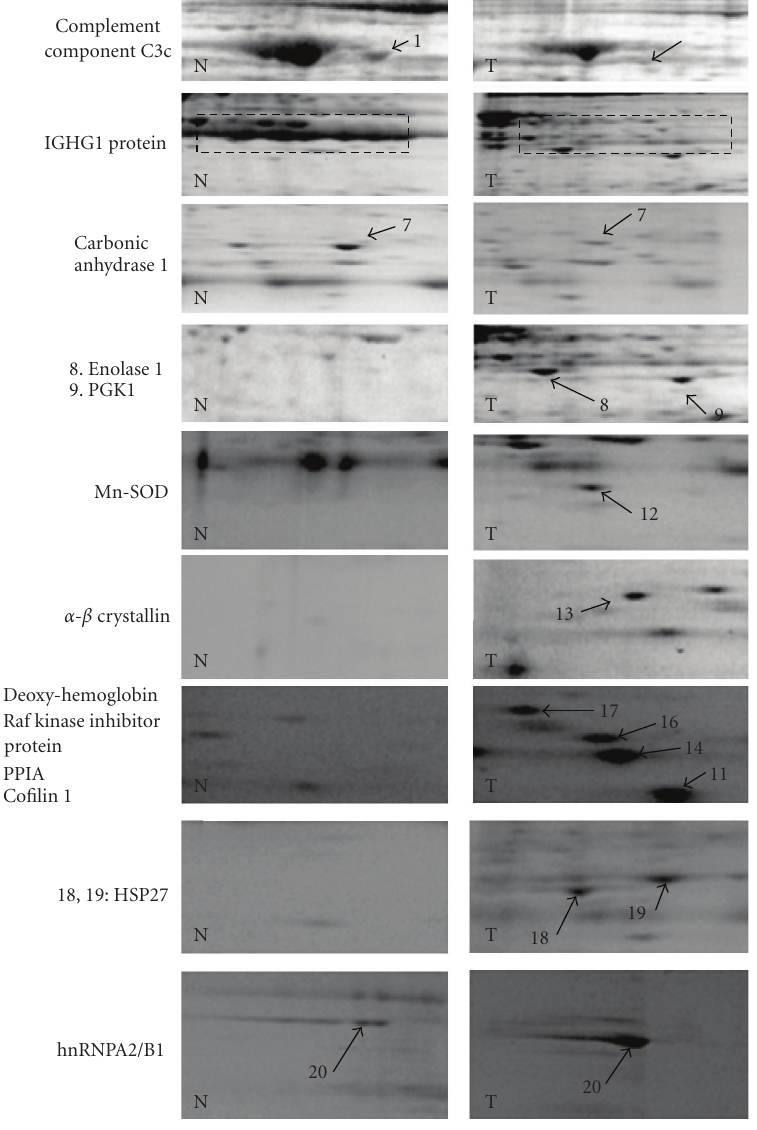
Figure 1: 2-DE pattern of proteins from tumor and nontumor samples resolved by NEPHGE 2-DE and listed in Table 1. Proteins dysreg- ulated in tumor tissues (T) as compared to nontumor tissues (N) are highlighted with arrows. The numbers indicated correspond to those given in Table 1. (1)–(7): proteins downregulated in tumor tissues; (8)–(20): proteins upregulated in tumor tissues. (1) complement com- ponent C3c; (2)–(6) IGHG1 protein isoforms; (7) carbonic anhydrase 1; (8) enolase 1; (9) phosphoglycerate kinase 1 (PGK1); (10), (11) hemoglobin; (12) MnSOD; (13) α -B crystallin; (14) Raf kinase inhibitor protein; (15), (16) peptidylprolylisomerase A (PPIA); (17) cofilin 1; (18), (19) HSP27; (20) hnRNP